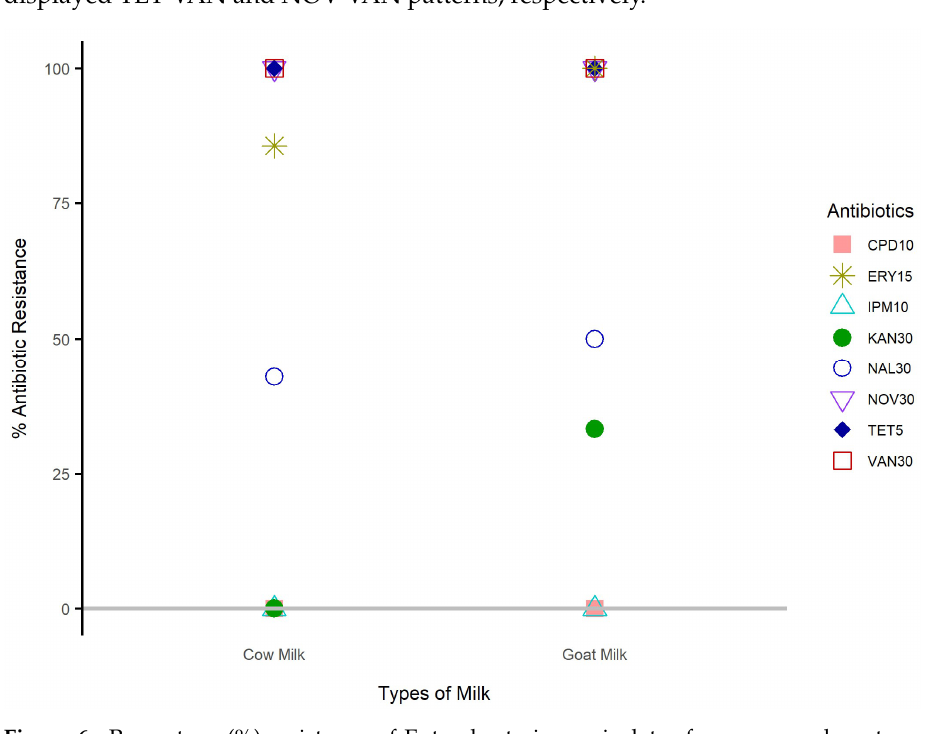
Figure 6. Percentage (%) resistance of Enterobacteriaceae isolates from cow and goat raw milk. CF1:Cattlle Farm 1; CF2:Cattlle Farm 2; GF: Goat Farm. Table 5. Antibiotic resistant patterns of Enterobacteriaceae species isolated from cow and goat milk.